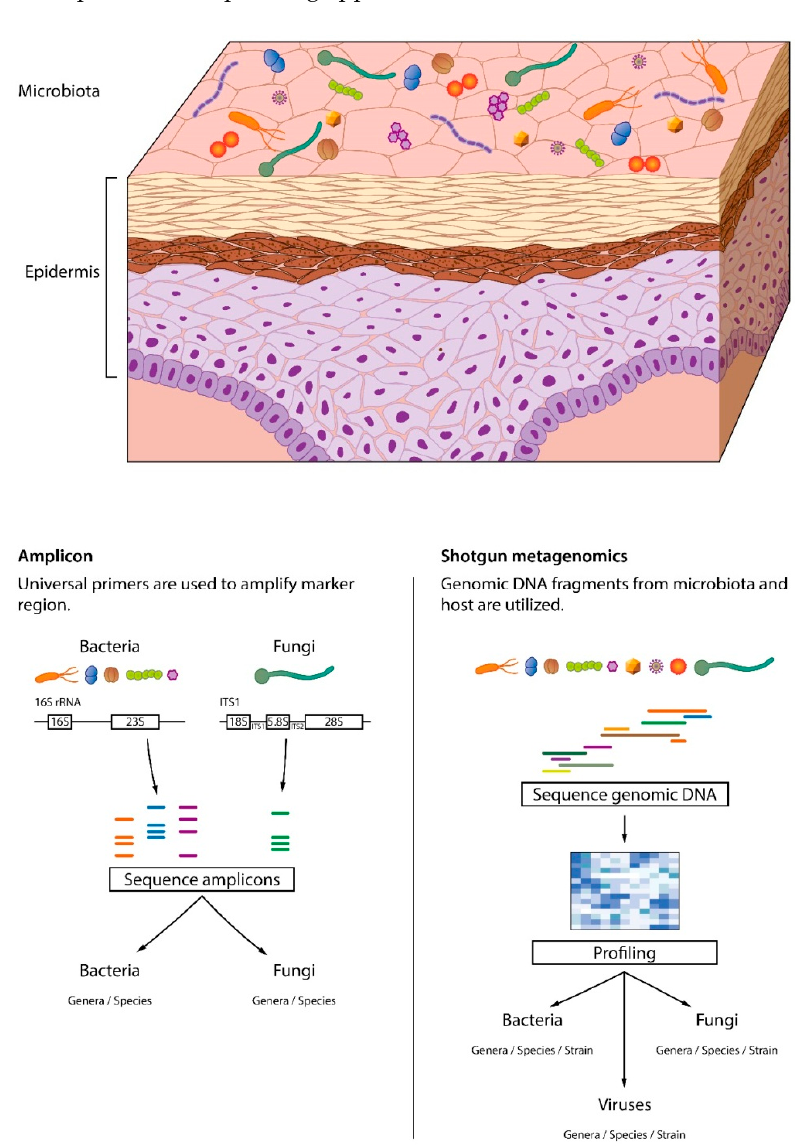
Figure 2. Amplicon and whole genome (shotgun) metagenomic sequencing. In amplicon sequencing, primers are used to amplify marker regions. Whole genome sequencing captures all the genetic information within a sample. Only shotgun metagenomics can identify viruses and o ff er resolution at the strain